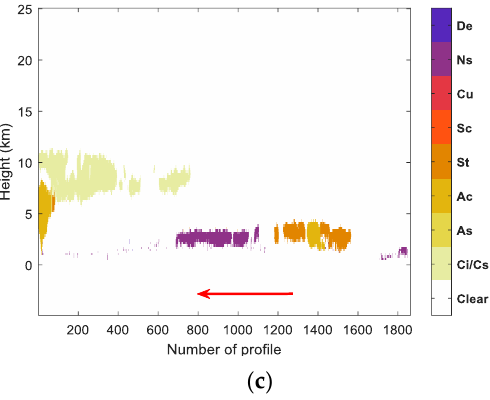
Figure 13. Classified result comparisons. ( a ) Is for the proposed strategy, ( b ) is for the method of the ISCCP [21,24,25], and ( c ) 2B-CLDCLASS [7,40] on the track. Different cloud types are labeled with different colors of the color bar. MLice means ice clouds overlap low level cloud, whereas MLwater means water clouds lie above. MODIS moves from bottom to top in ( a , b ). Arrowhead indicates the CPR motion direction in ( c ).